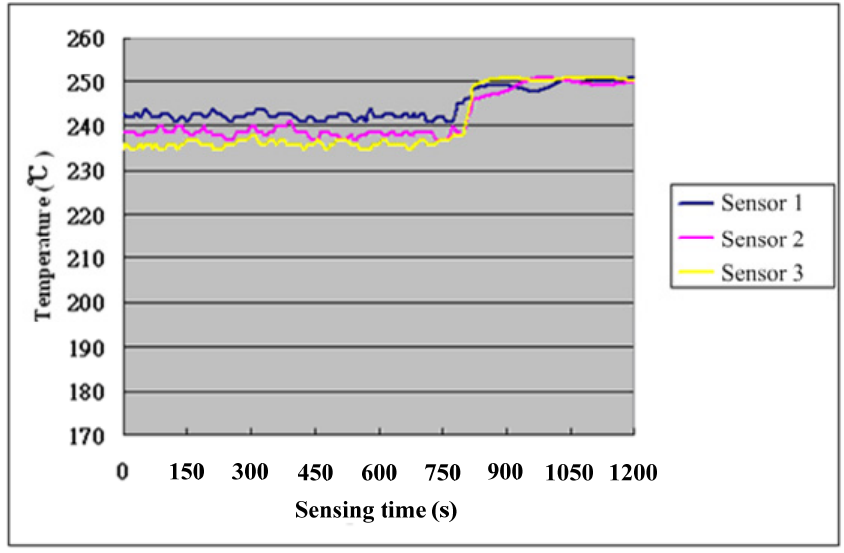
Figure 8. Temperature distribution of micro sensors 1 ~ 3 insider the reformer.